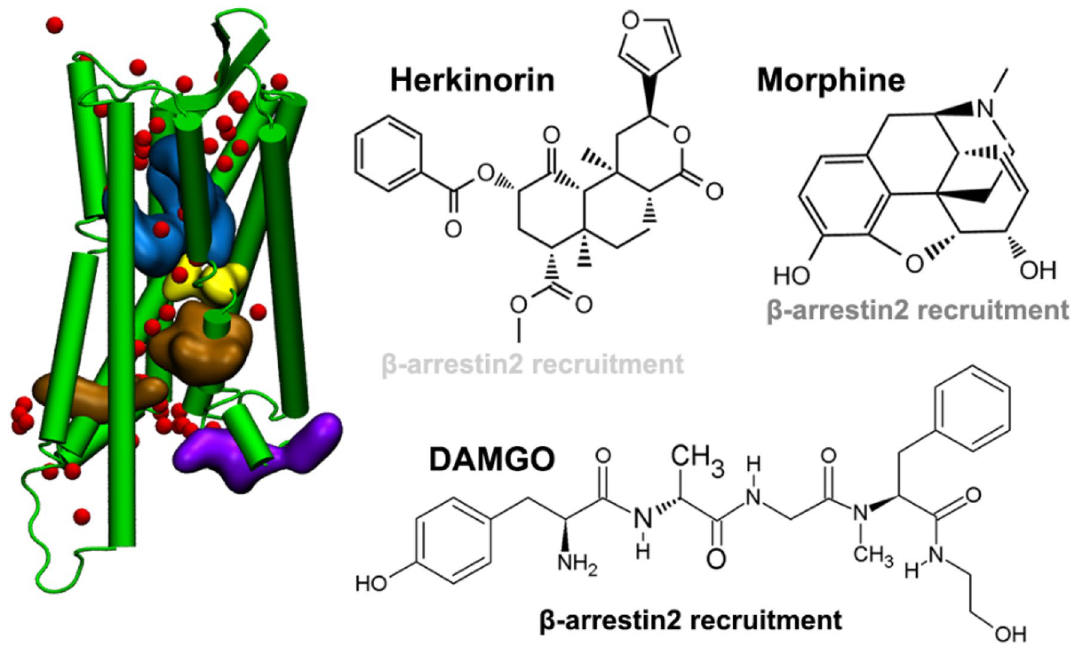
shown to the right. As reference, the trend of β-arrestin2 recruit- ment is shown in grayscale underneath the chemical structures. Darker color represents higher recruitment based on βarr2-GFP assays